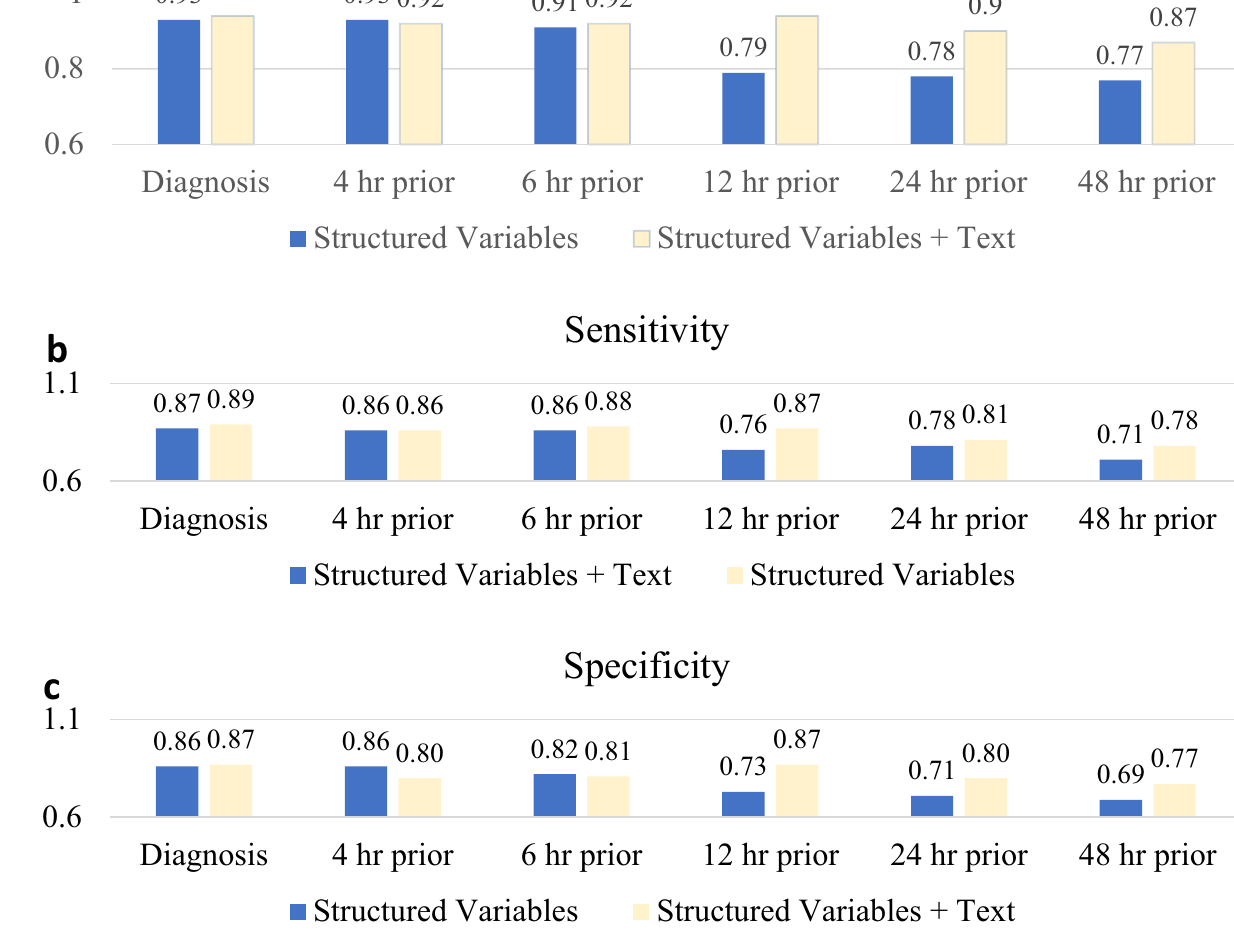
Fig. 4 Comparing SERA algorithm performance with models without clinical text. We measure the change in performance for each diagnosis and prediction model when clinical text is added as additional predictors. Structured variables represent the models that only include vitals, investigations, and treatment data as predictors. Structured variables + text represent the models have additional clinical notes as predictors. a Compares the AUC of models with and without clinical notes. b Compares the sensitivity of models with and without clinical notes. c Compares the speci fi city of models with and without clinical